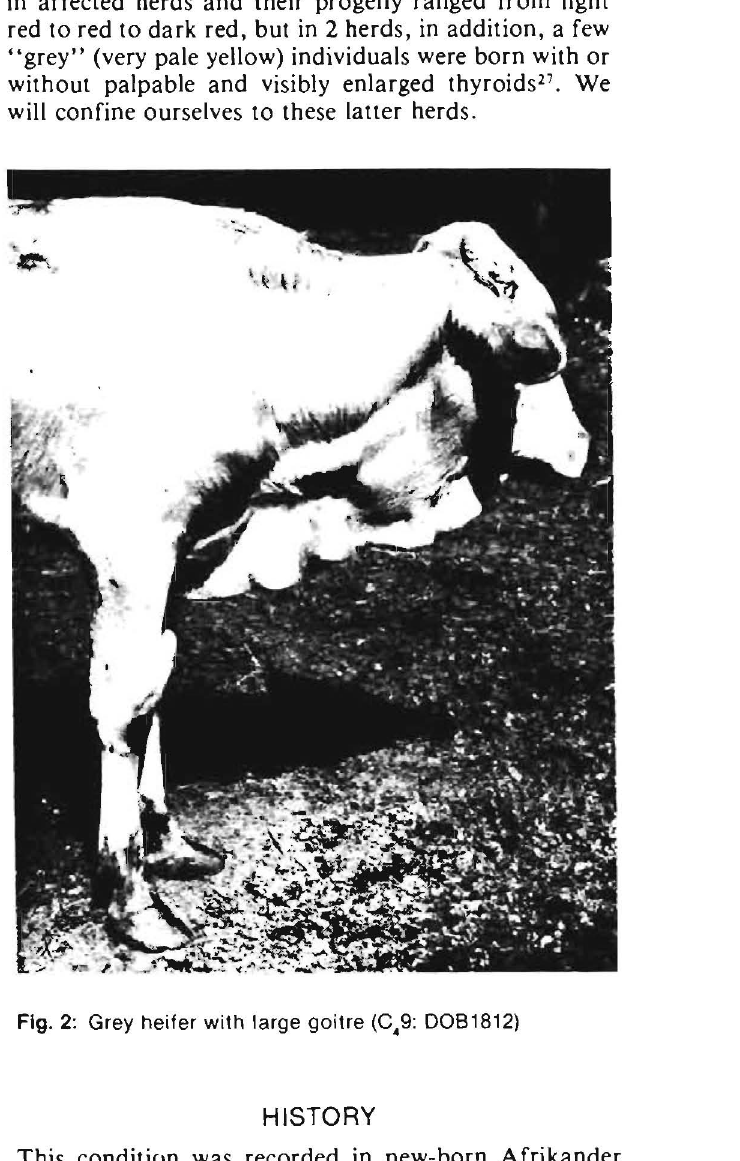
Fig. 2: Grey heifer with large goitre (C,g: 0081812)